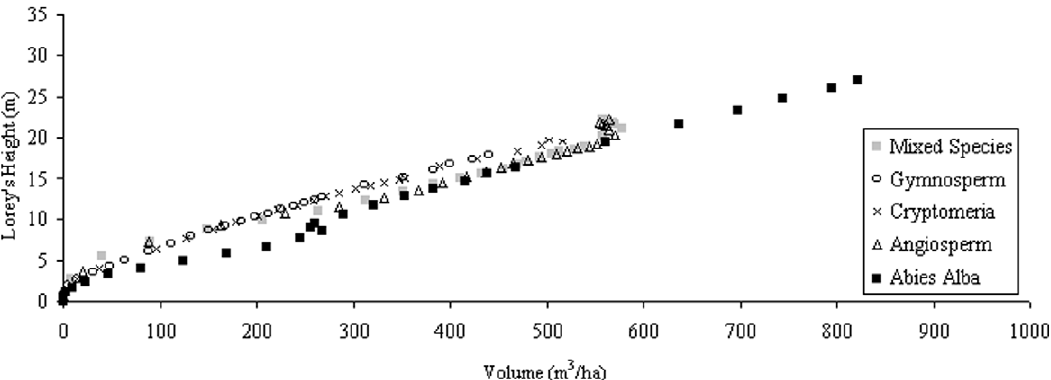
Figure 4. H max within forests of initial planting density of 10000 stems ha. 2 1 plotted alongside H mean values where indicated in the legend.